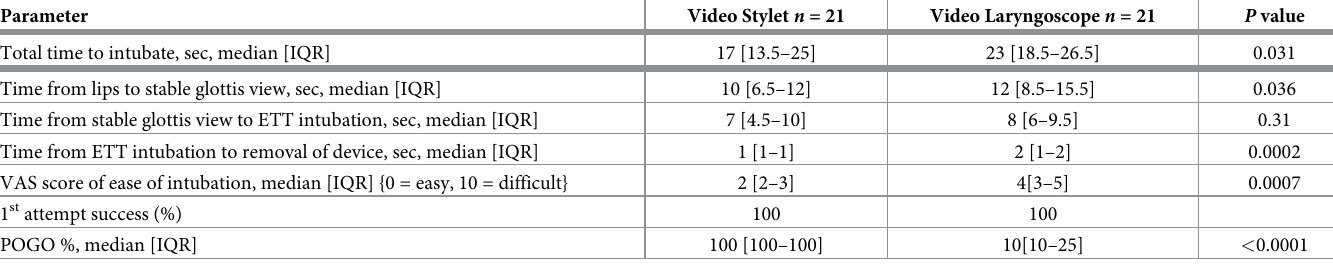
Table 2. Intubation metrics of difficult airway.